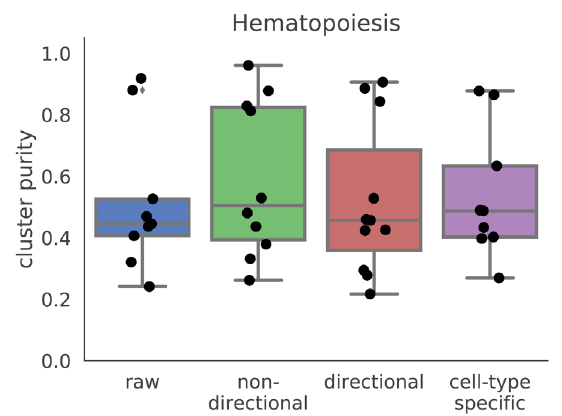
Figure 9. Cluster purities after applying netSmooth with different input networks. Raw refers to no smoothing, non-directional is the same as the results shown in previous sections. Directional refers to a gene network where inhibitory relationships have negative edge weights, and cell-type specific refers to a gene network of only genes which are known to have cell-type specific expression patterns. The online version of this figure is interactive.